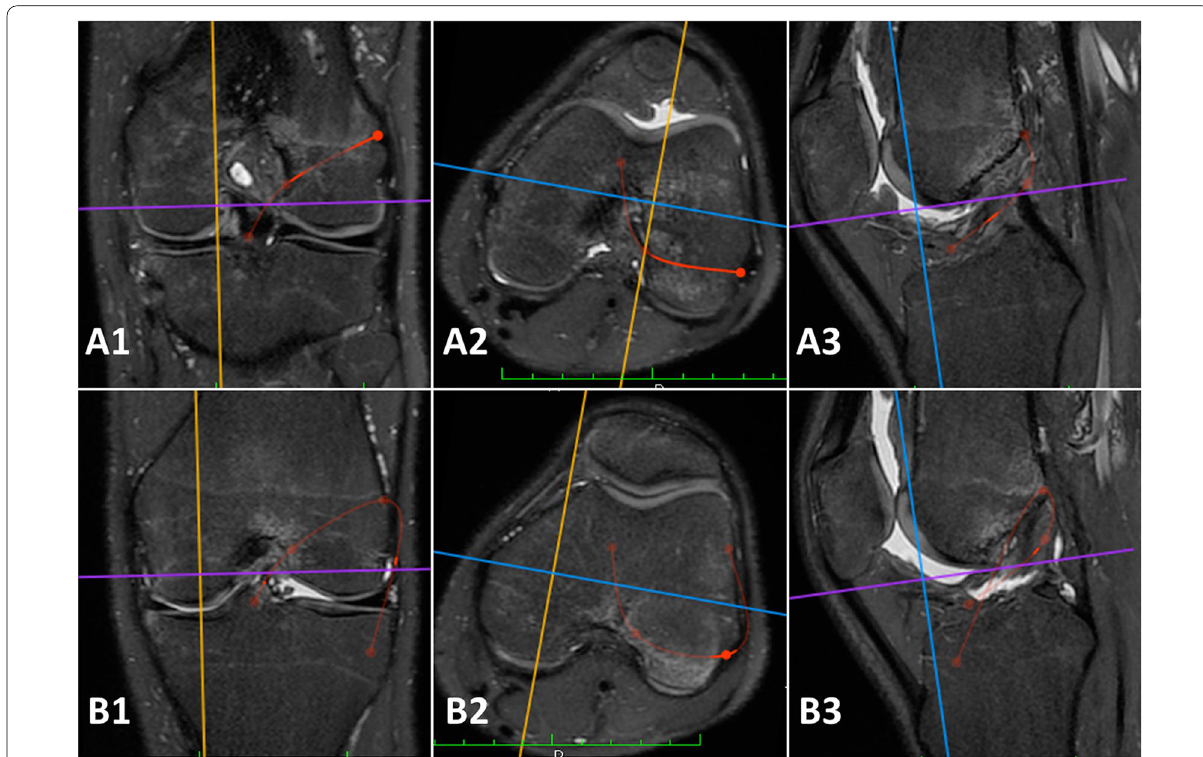
Fig. 2 3D measurements performed on the 3D MRI sequences (Turbo Spin Echo T2 weighted 3D MRI with isotropic voxel). A Red lines: single bundle outside-in anatomic ACL reconstruction (SBOI) defined as the sum of intrarticular length of the graft (IAGL) and Outside-in femoral tunnel (OIFT). Particularly, A1 is the coronal view, A2 axial view, and A3 sagittal view of a left knee with simulation of the same reconstruction. B Red lines: Saragaglia and Yamaguchi technique (SYT) defined as the sum intrarticular length of the graft (IAGL), outside-in femoral tunnel (OIFT) and modified Lemaire lateral extrarticular tenodesis, anatomical on the femur (ALET). Particularly, B1 is the coronal view, B2 is the axial view, and B3 is the sagittal view of a left knee with simulation of the same